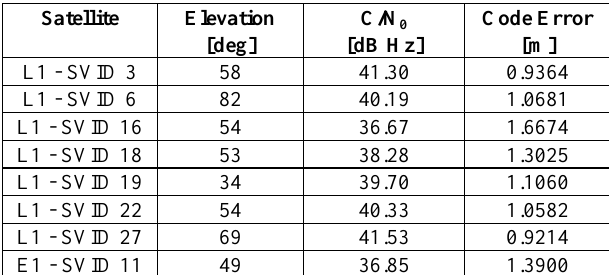
Table 2. Elevation, C/N 0 and code error for all visible satellites